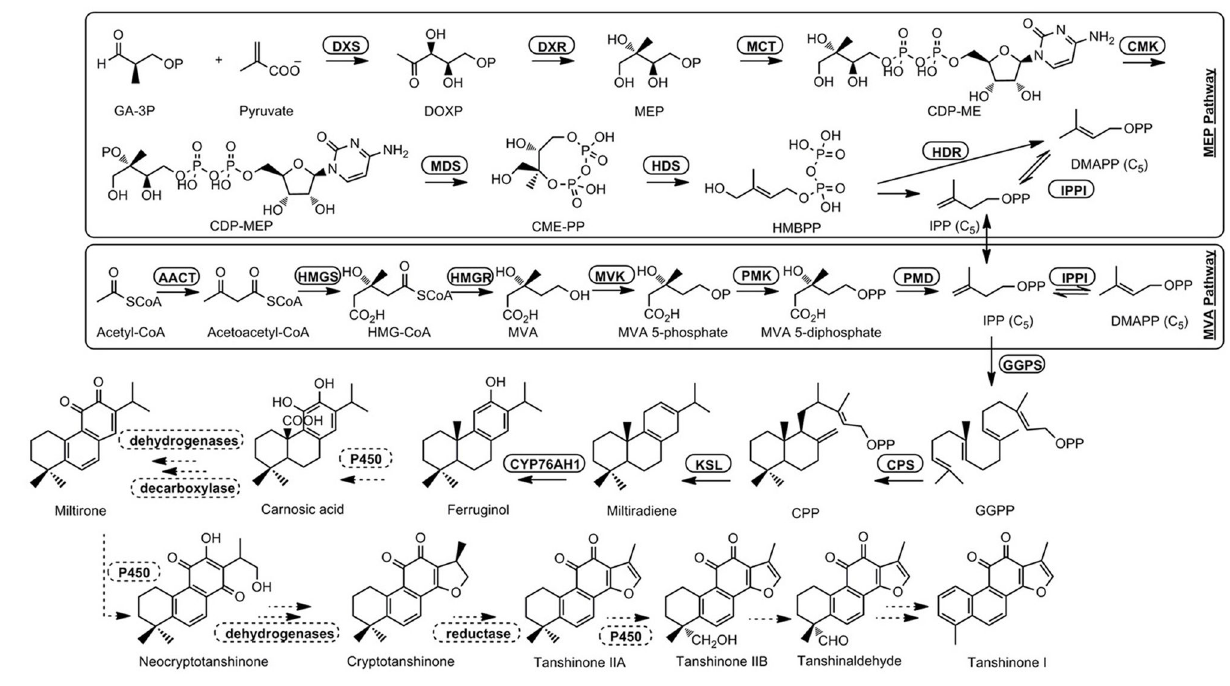
Figure 1. Biosynthetic pathway of tanshinone compounds. The solid arrows denote known steps and the dashed arrows denote hypothetical steps. Modified from Ma et al. and Gao et al. [7,13]. Enzymes of 2-C-methyl-D-erythritol 4- phosphate (MEP) pathway are follows: 1-deoxy-D-xylulose-5-phosphate synthase (DXS), 1-deoxy-D-xylulose-5-phosphate reductoisomerase (DXR), 2-C-methyl-D-erythritol 4-phosphate cytidylyltransferase (MCT), 4-diphosphocytidyl-2-Cmethyl-D-erythritol kinase (CMK), 2-C- methyl-D-erythritol 2,4-cyclodiphosphate synthase (MDS), 4-hydroxy-3-methylbut-2-enyl diphosphate synthase (HDS), 4-hydroxy-3- methylbut-2-enyl diphosphate reductase (HDR); and enzymes of mevalonate (MVA) pathway are acetyl-CoA acetyltransferase (AACT), 3-hydroxy-3-methylglutaryl-CoA synthase (HMGS), 3-hydroxy-3-methylglutaryl-CoA reductase (HMGR), mevalonate kinase (MVK), 5-phosphomevalonate kinase (PMK) and 5-diphosphomevalonate decarboxylase (PMD). Isopentenyl diphosphate isomerase (IPPI) catalyzes the isomerisation of dimethylallyl dihosphate (DMAPP) to isopentenyl diphosphate (IPP) whereas conversion of IPP to geranylgeranyl diphosphate (GGPP) is catalysed by geranylgeranyl diphosphate synthase (GGPPS). Hypothetical tanshinones biosynthetic pathway was deduced by the consideration of identified diterpenoid natural products from S. miltiorrhiza [56,57]. These steps involve series hydroxylation, dehydrogenation and reduction reactions catalysed by cytochrome P450s, dehydrogenases and